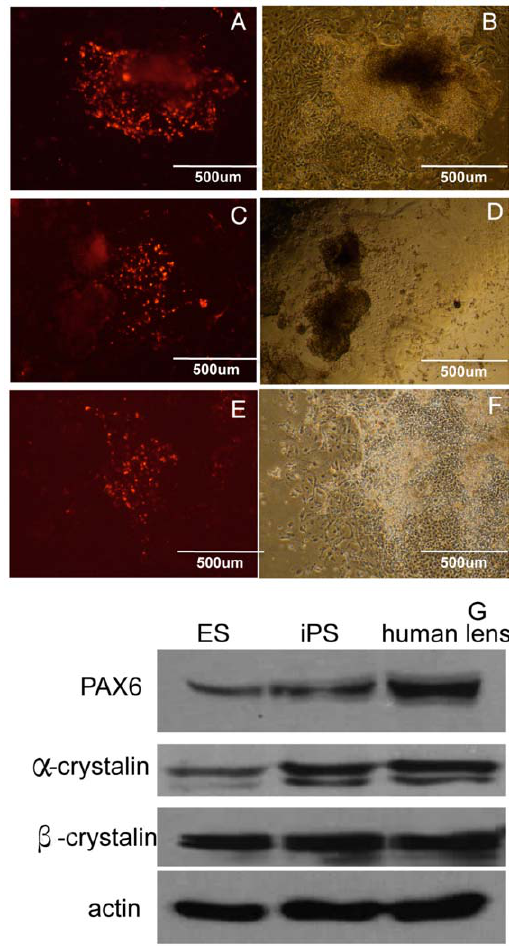
Figure 5. HLEC-iPSCs can be highly efficiently induced to express mature lens cell markers during initial differentiation. The expression of PAX6, a -crystallins and b -crystallins in HLEC-iPSCs differentiated into lens progenitor cells at d 10 following infection is shown. The immunofluorescent detection of PAX6 (red, A, B) is shown, a - crystallin (red, C, D) and b -crystallin proteins (red, E, F). (G) Western blot analysis of protein expression during the differentiation of HLEC- iPSCs. Specific antibodies were used to detect expression of PAX6, a - crystallin and b -crystallin. Expression of actin is shown as a loading